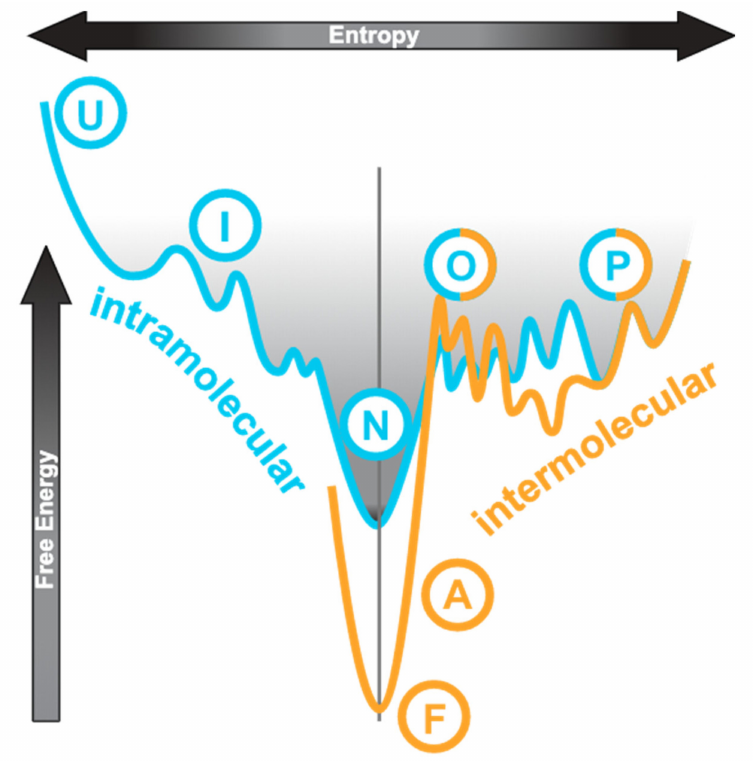
Figure 1. Conceptual relationship of conformational states involved in diseases. This shows a cross- section through an energy funnel with entropy as the horizontal axis and free energy as the vertical axis. The left half of the cyan curve represents a generic folding via intermediate path from unfolded (U), (I), to native (N) states. For intrinsically disordered proteins (IDPs), the native state is partially folded (P) or can easily become so since the free energy difference is small and it is characterised by multiple states including the oligomers, as illustrated by the right half of the cyan curve. The orange curve to the right is the misfolding funnel, also with the partially folded (P) and oligomeric (O) states. In diseases, a structural transition occurs in either the partially folded state or the oligomeric state, leading to stable amorphous aggregates (A) or fibrils (F). The normal folding pathway is dominated by intramolecular contacts whereas the misfolding pathway by intermolecular interactions. This figure is adapted and modified from this source [22]. Moreover, see this for a discussion of the IDP energy landscape